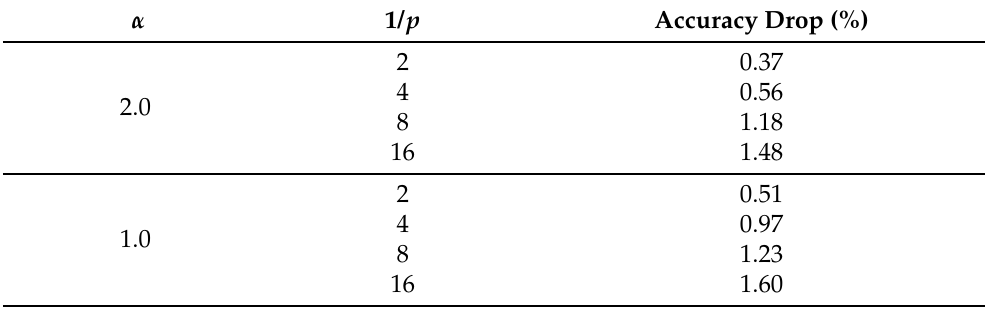
Table 8. Partitioning impact effectiveness of SG according to partition size and α .